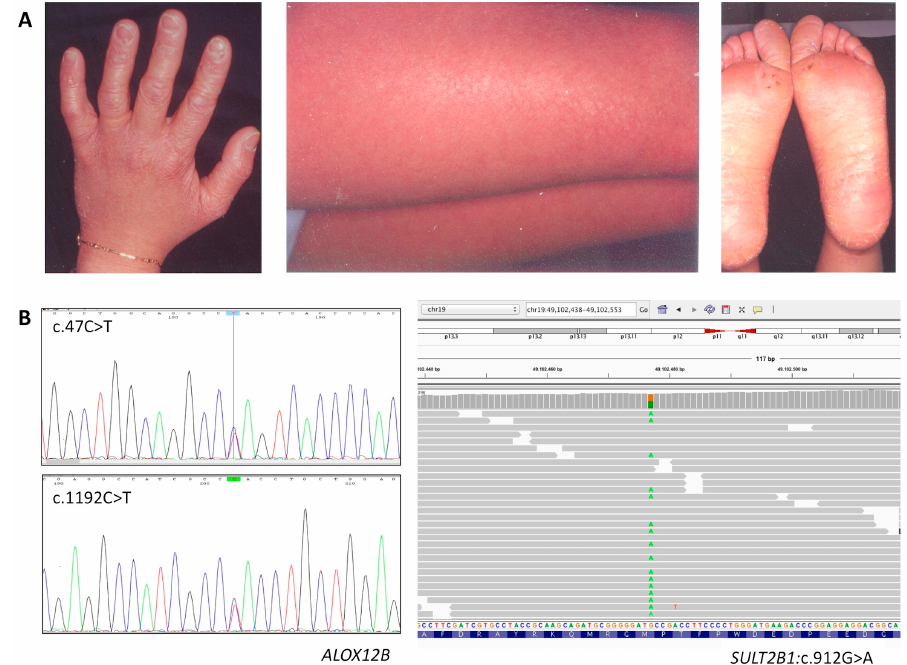
Figure 2. Phenotypic and genetic features of patient 2. ( A ) Marked palmoplantar keratosis and fine scaling with diffused erythroderma on the leg are shown. ( B ) Sanger sequencing electropherograms showing the nucleotide changes leading to the missense variants p.Ser16Leu and p.His398Tyr in ALOX12B ( left ); Interactive Genomics Viewer (IGV) detail of the variant revealing heterozygosity of the SULT2B1 c.912G>A (p.Met304Ile) sequence change ( right ); the read depth for this nucleotide position is 162X, with the variant A allele sequenced 80X.